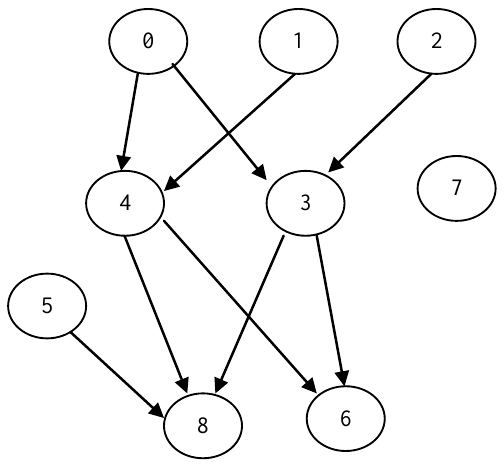
Figure 4. Precedence constraints Directed Acyclic Flow Graph.